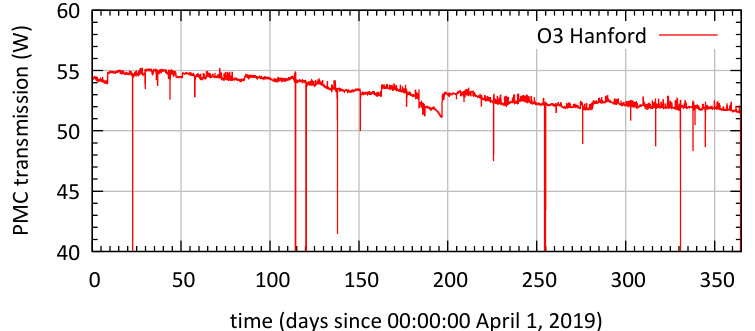
Figure 5. The power transmitted by the PMC at the LIGO site in Hanford. The fully operational pre-stabilized laser system (PSL) was available for the whole observation run. The total power decrease over time from 55W to 52W was due to alignment and HOM content